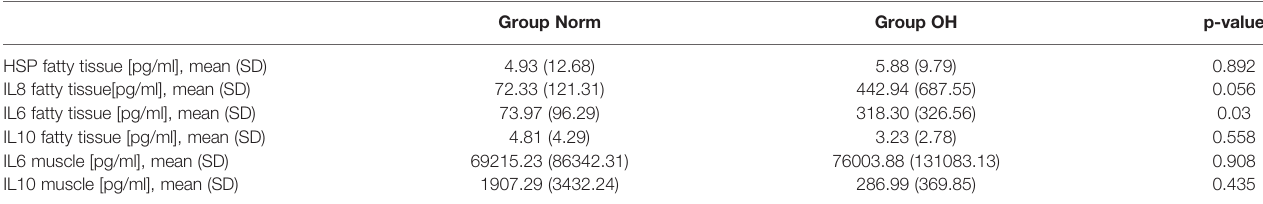
TABLE 3 | Occult hypoperfusion is associated with increased local in fl ammatory response of the injured soft tissue at the fracture. Group